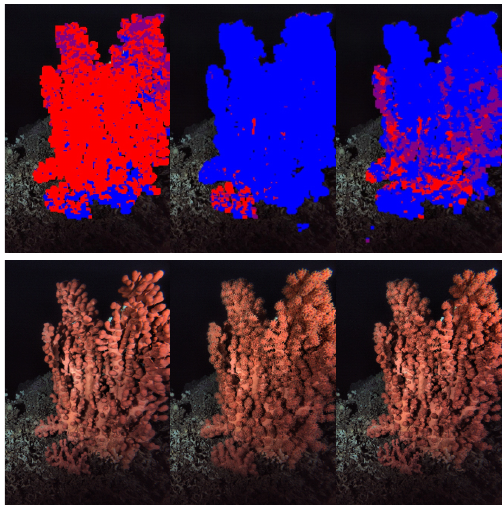
Figure 8. Examples of coral segmentation indicting activity status ( above ) and original images ( below ). Non-bloated areas are in red and bloated ones are in blue. Purple areas are in the transient semi-bloated condition. Table 2. Precision Accuracy (PA) and User Accuracy (UA) of each of the 4 state categories.